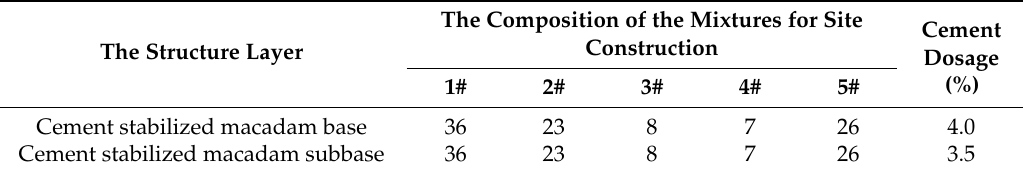
Table 5. The composition of the mixtures for cement stabilized macadam base.